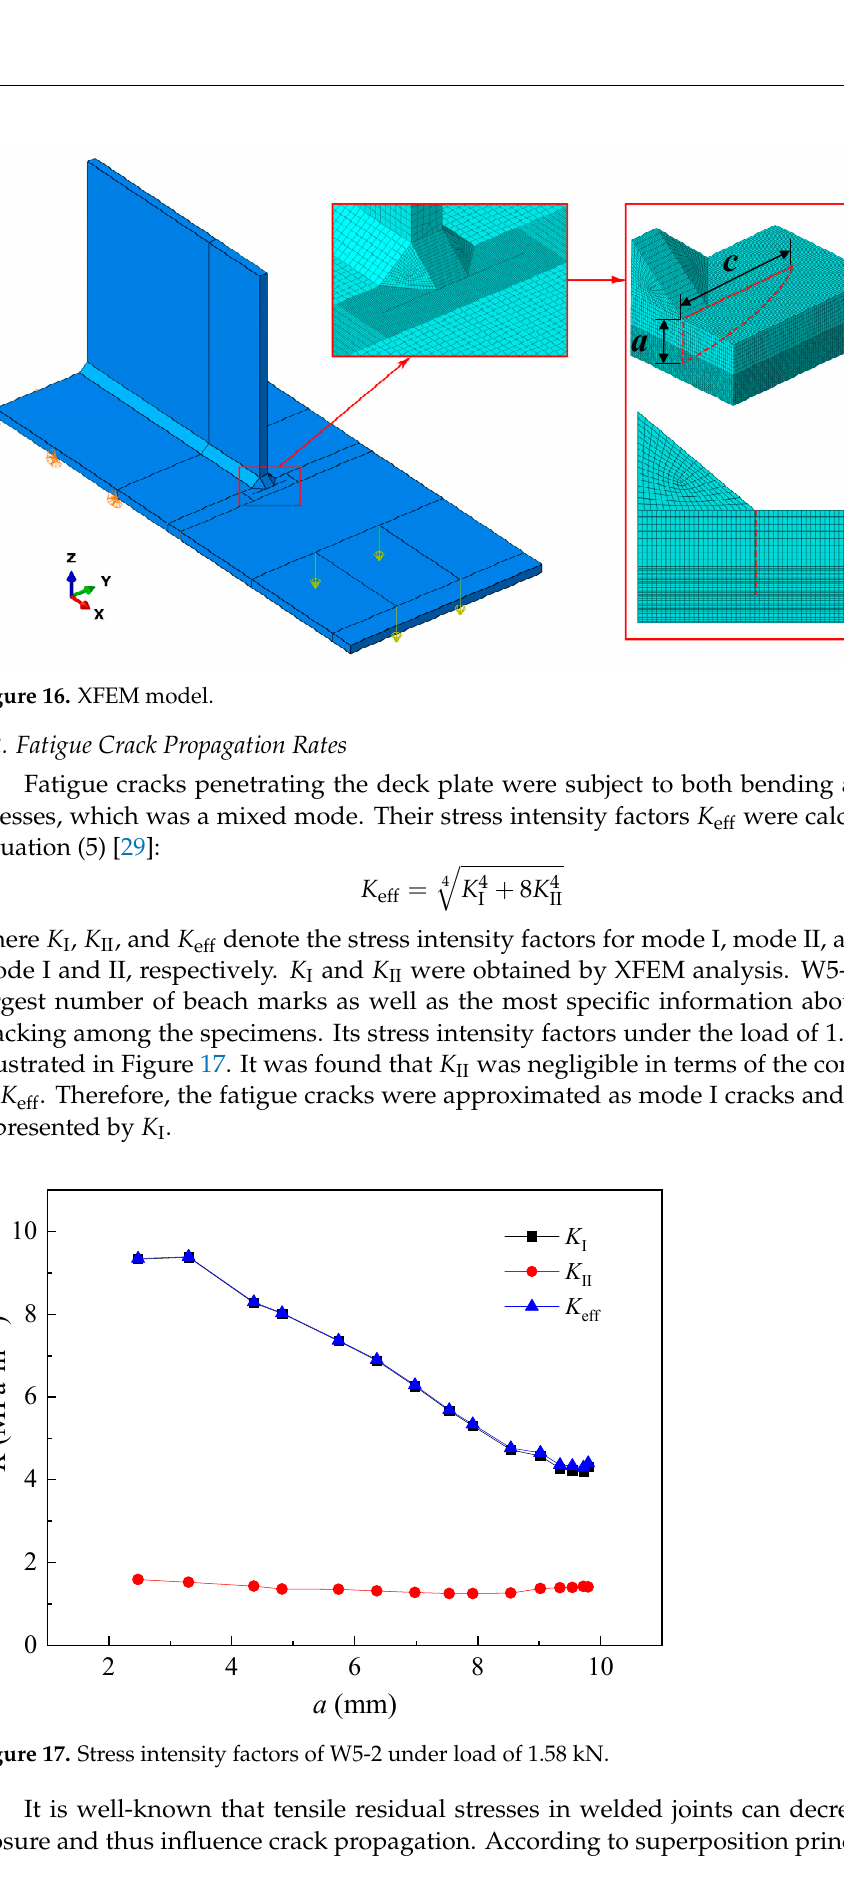
Figure 17. Stress intensity factors of W5-2 under load of 1.58 kN.